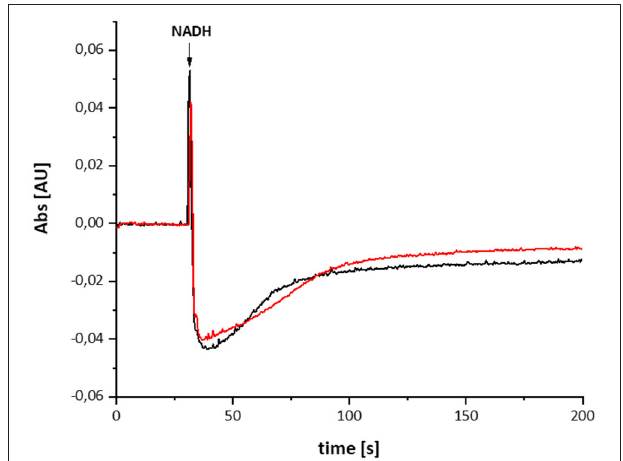
FIGURE 7 | Reduction of the wild type complex (black) and the D213G H variant (red) by NADH. The trace of the absorbance at 450nm is shown. The variant re-oxidizes significantly slower than the wild type